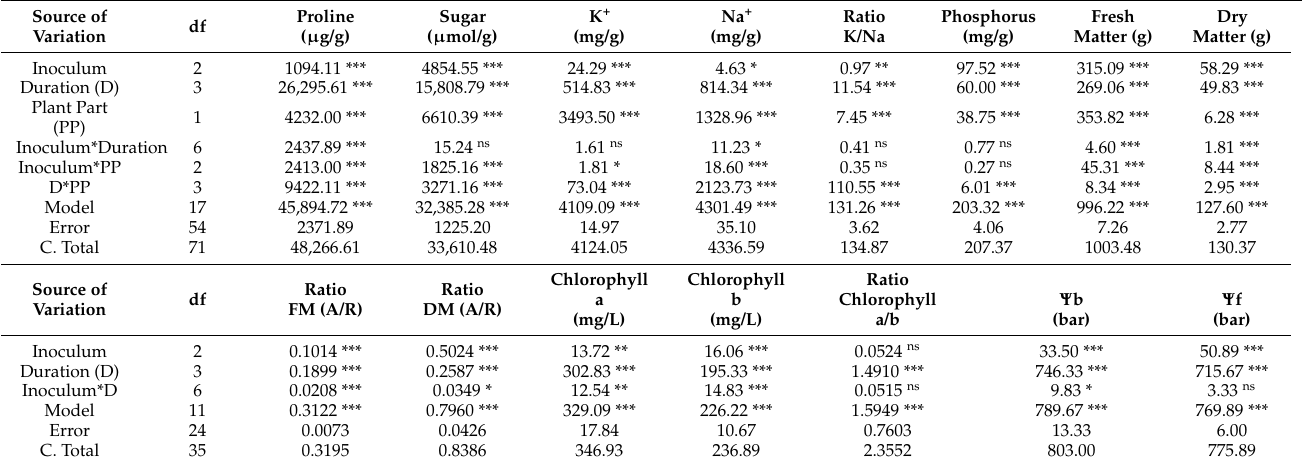
Table 2. Result of the Analysis of the Variance of the Means of the Measured Parameters, Depending on the Inoculum, Duration, and Plant